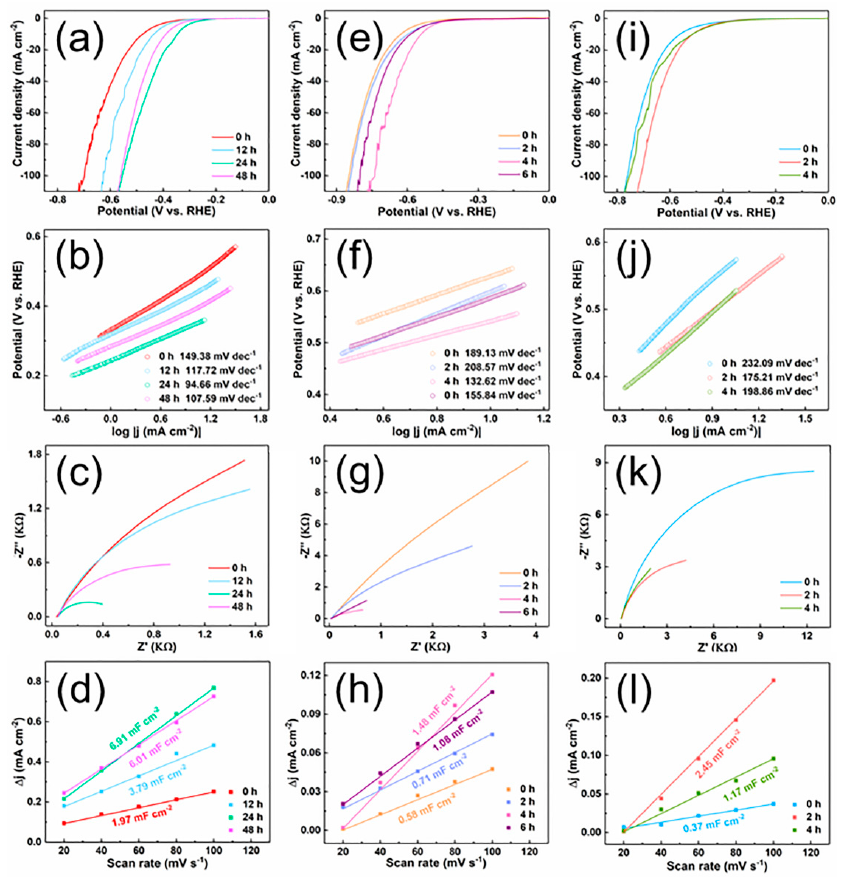
Figure 8. The LSV curves of ( a ) TiB 2 , ( e ) ZrB 2 , ( i ) HfB 2 with different etched time for HER in 0.5 M H 2 SO 4 solution, the tafel slopes of ( b ) TiB 2 , ( f ) ZrB 2 , ( j ) HfB 2 with different etched time, EIS Nyquist plots of ( c ) TiB 2 , ( g ) ZrB 2 , ( k ) HfB 2 with different etched time, ECSA fitting curves of ( d ) TiB 2 , ( h ) ZrB 2 , ( l ) HfB 2 with different etched time.